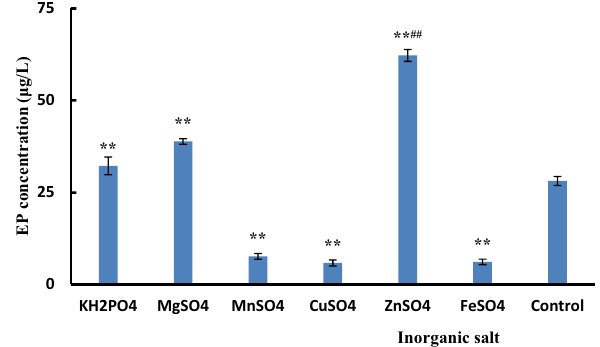
Figure 3. Effect of inorganic salt sources on the EP concentration. The control was the medium without inorganic salt.** p ≤ 0.01, compared with the control group; ## p ≤ 0.01, compared with the groups when KH 2 PO 4 and MgSO 4 were added, respectively. The other components of the medium were the same, and the culture was carried in a rotary shaker at 25 °C and 120 rpm for 48 h.